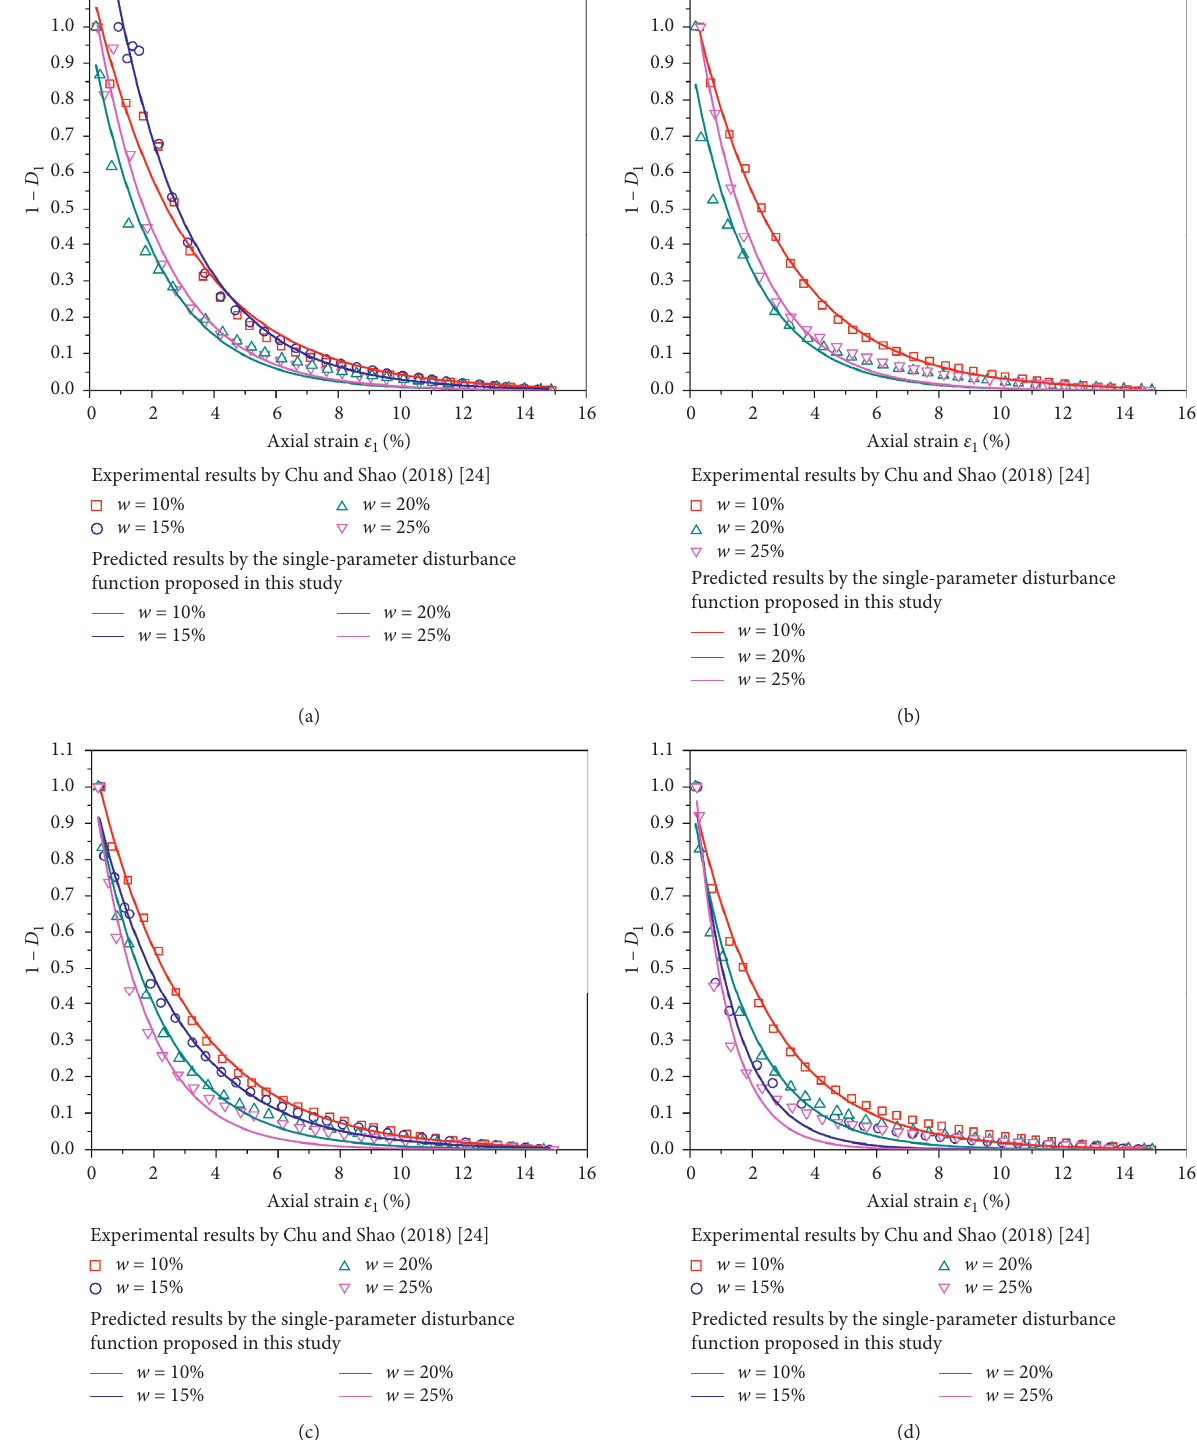
Figure 9: Validation of the single-parameter disturbance function against the experimental results by Chu and Shao [24] at different moisture contents and confining pressures. (a) σ 3 � 100kPa; (b) σ 3 � 200kPa; (c) σ 3 � 300kPa; (d) σ 3 � of the structural disturbance. The performance of the (1) The single-parameter disturbance function, fitted as single-parameter disturbance function in describing an exponential function with the secant modulus as undisturbed loess soil is remarkable. its parameter, is capable of quantifying the strength